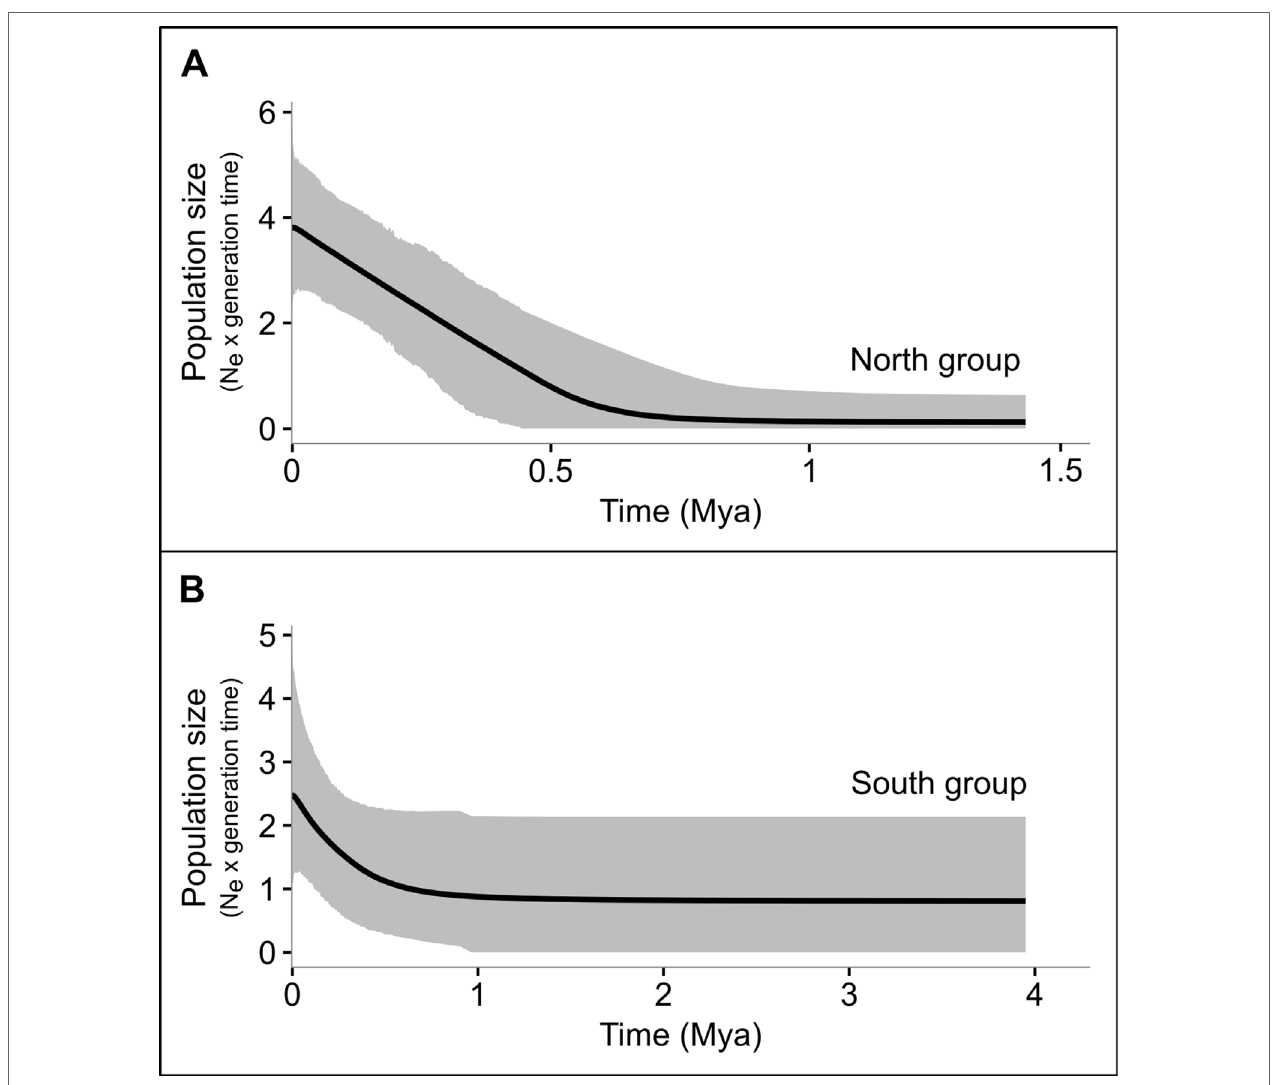
FIGURE 5 | Multilocus extended Bayesian skyline plots (EBSP) illustrating effective population sizes (Ne × generation) though time (in Mya) of the north (A) and South (B) groups of P. nordestinus . Gray shades represent the 95% higher posterior density intervals.